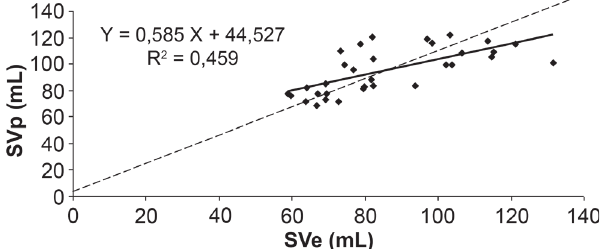
Fig 8. Correlation plots between SVe and SVp computed with the systolic area method. —— : equality